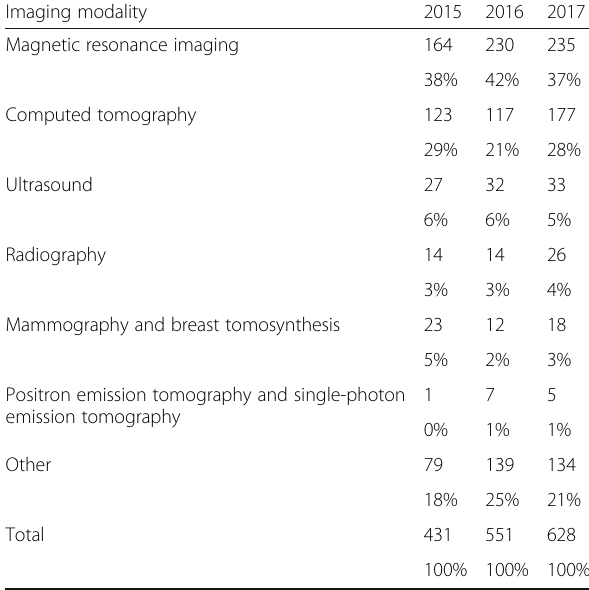
Table 1 Number of articles on AI in radiology indexed on EMBASE, stratified by imaging modality Imaging modality Magnetic resonance